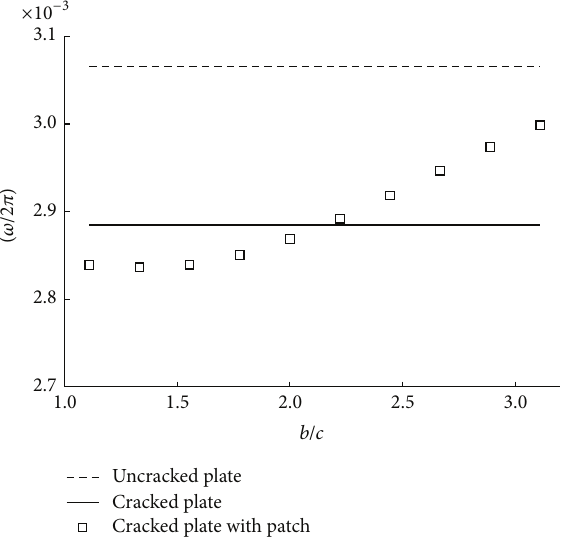
Figure 6: Variation of natural frequencies with crack size.